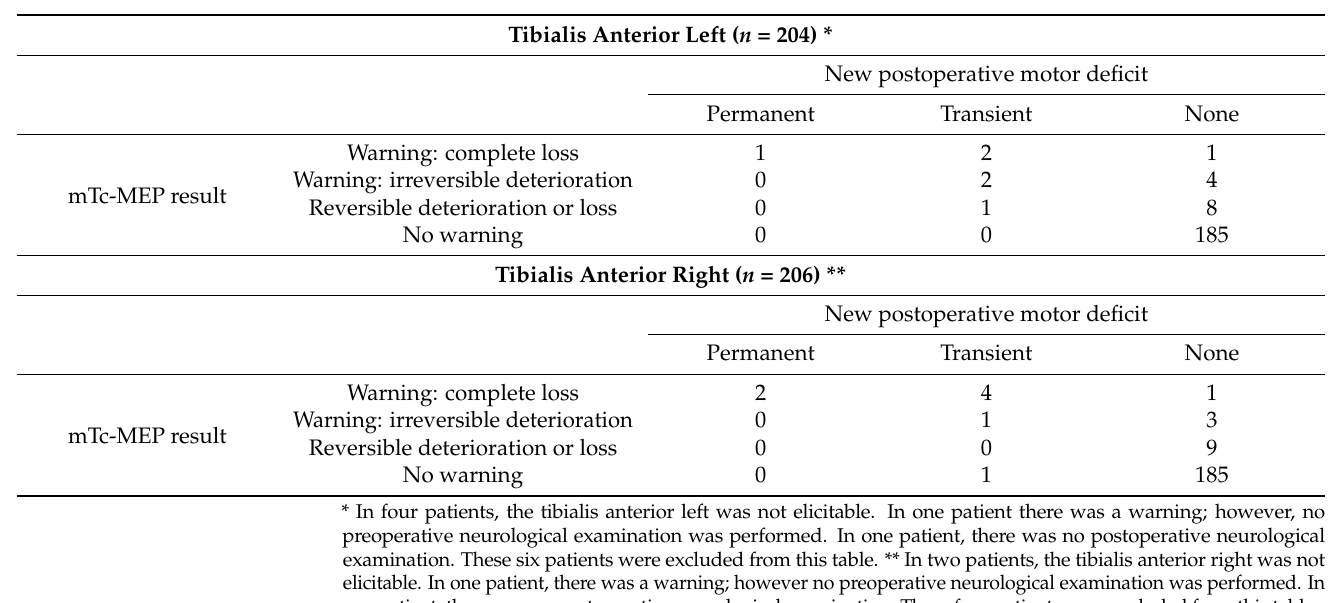
Table 5. Number of patients with an mTc-MEP warning in the left TA and right TA separately for both surface and subcutaneous needle recording electrodes.